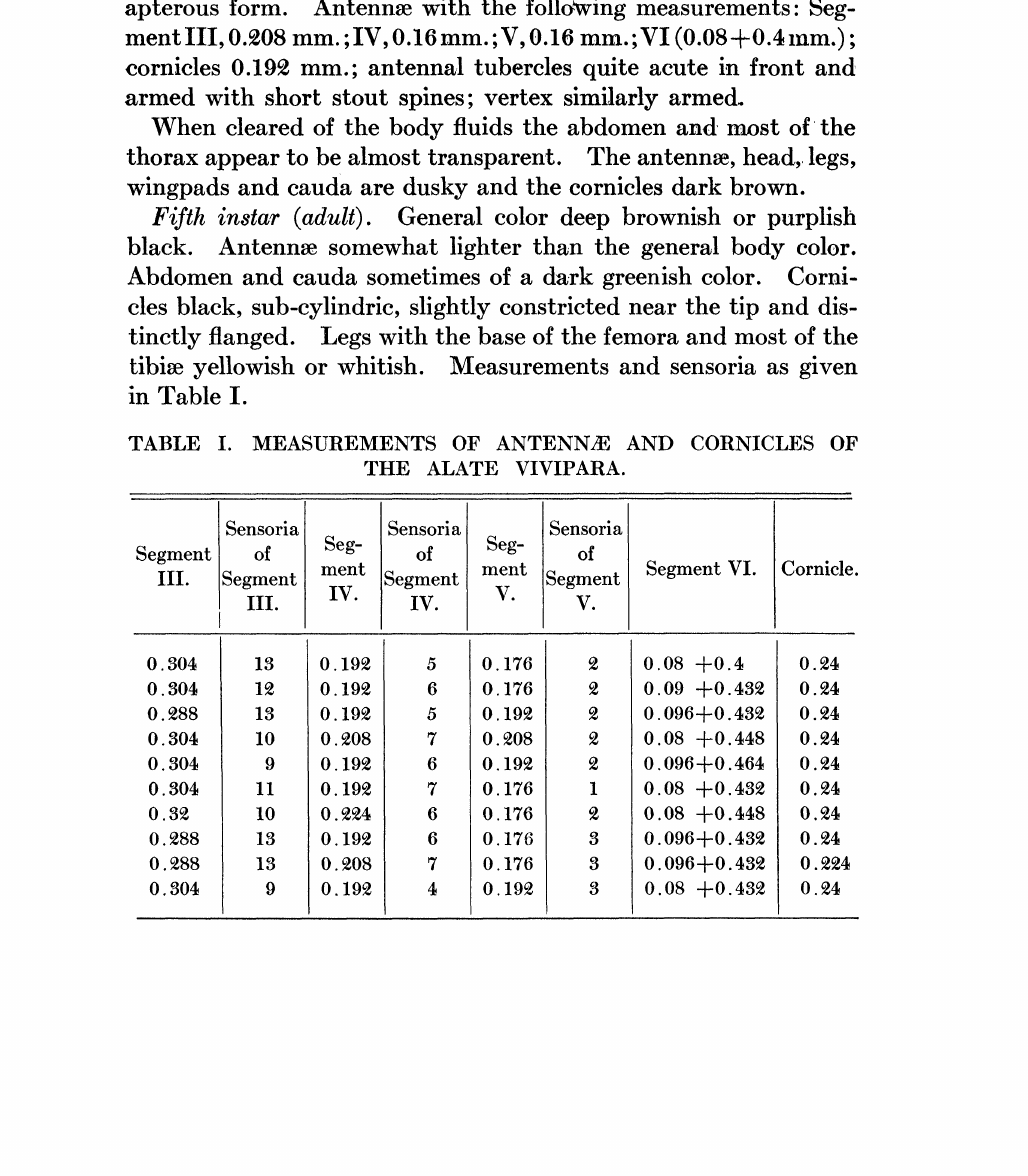
TABLE I. MEASUREMENTS OF ANTENNAE AND CORNICLES OF THE ALATE